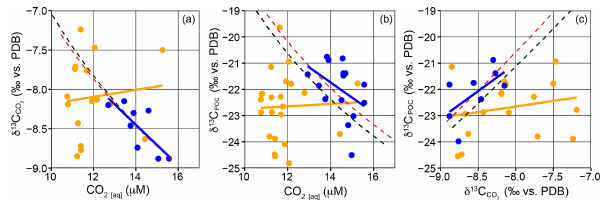
Figure 2. Correlations between [CO 2 ( aq ) ], δ 13 C POC and δ 13 C CO 2 vs. [CO 2 ( aq ) ], (b) δ 13 C POC vs. in surface waters. (a) δ 13 C CO 2 . Blue points represent [CO 2 ( aq ) ] and (c) δ 13 C POC vs. δ 13 C CO 2 SASW samples, and orange points represent subtropical samples. A linear regression for each region is shown in the respective colours; all regressions were insignificant ( p> 0 . 05), apart from SASW sam- ples in (a) where r = − 0 . 77, n = 12 and p = 0 . 003. The dashed lines display the expected trend due to diffusive uptake of carbon by phytoplankton using temperature and not cell size, red refers to atmospheric CO 2 350ppm, 1.7‰, (Rau et al., 1996), black is 390ppm, 1.3‰ (representative of this study). Figure 3. Distribution of (a) [CO 2 ( aq ) ], (b) δ 13 C CO δ 13 C POC vs. longitude. Closed circles and solid lines show mea- sured values and trends, orange lines and points equal 5m and blue lines and points equal 20m. In (a) and (b) , dashed lines are mod- elled estimates using temperature only (Rau et al., 1996). Long dashes refer to an atmospheric CO 2 of 390ppm, and dotted lines refer to atmospheric CO 2 of 350ppm. In (c) , dashed lines are mod- elled estimates using temperature, [CO 2 ( aq ) ] and δ 13 C CO shaded areas highlight the stations sampled north of the SSTC. Green shaded bars represent 2 σ for the SACW, SASW and AC re- gions of the